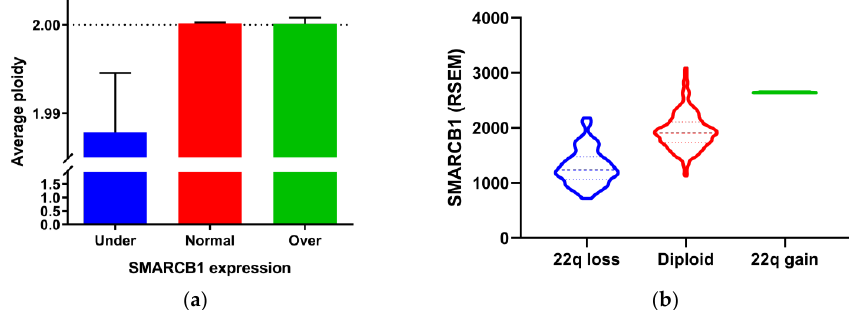
Figure 4. Associations between SMARCB1 gene expression and genetic alterations in papillary thyroid cancer (THCA) dataset from The Cancer Genome Atlas (TCGA). ( a ) Bar graph showing the median ploidy of tumors with underexpression, normal expression, and overexpression of SMARCB1. Error bars indicate interquartile range. ( b ) Violin plot showing SMARCB1 expression levels grouped by somatic copy number alterations of chromosome 22q. RSEM: RNA-Seq by Expectation Maximization.